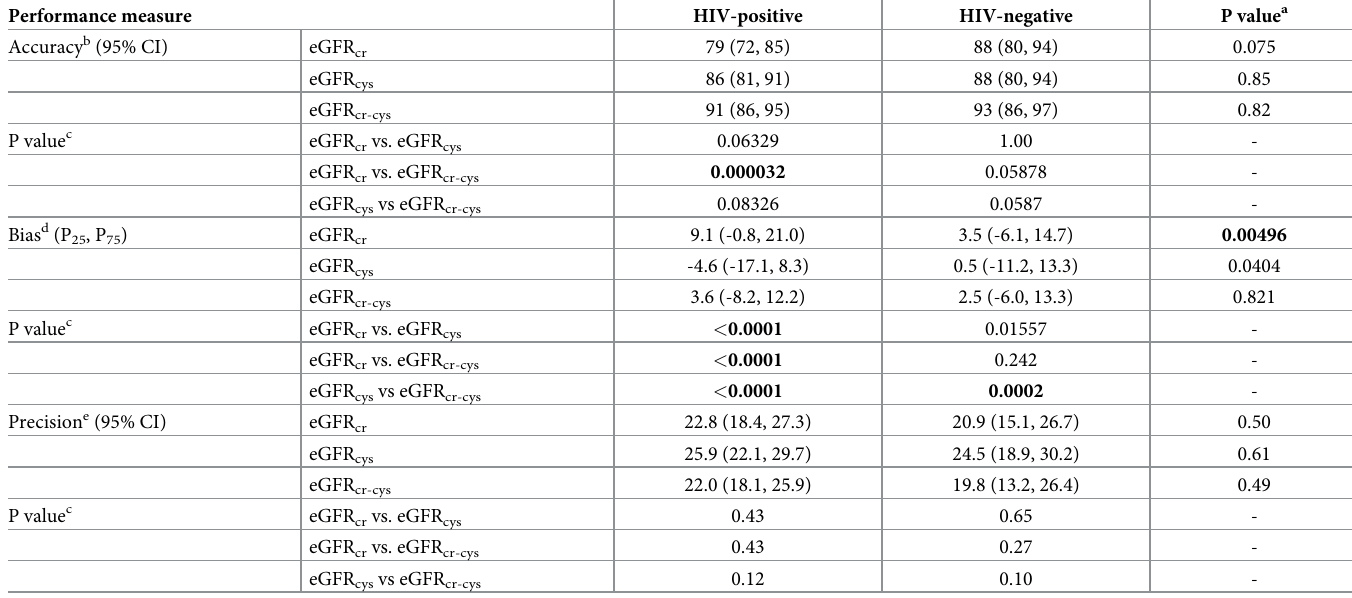
Table 2. Performance of glomerular filtration rate estimating equations in HIV-positive and HIV-negative participants. Performance measure